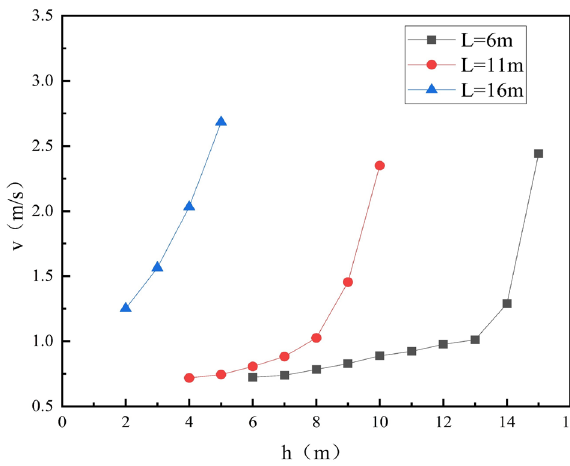
Figure 7. Variation of v with h at different within the control